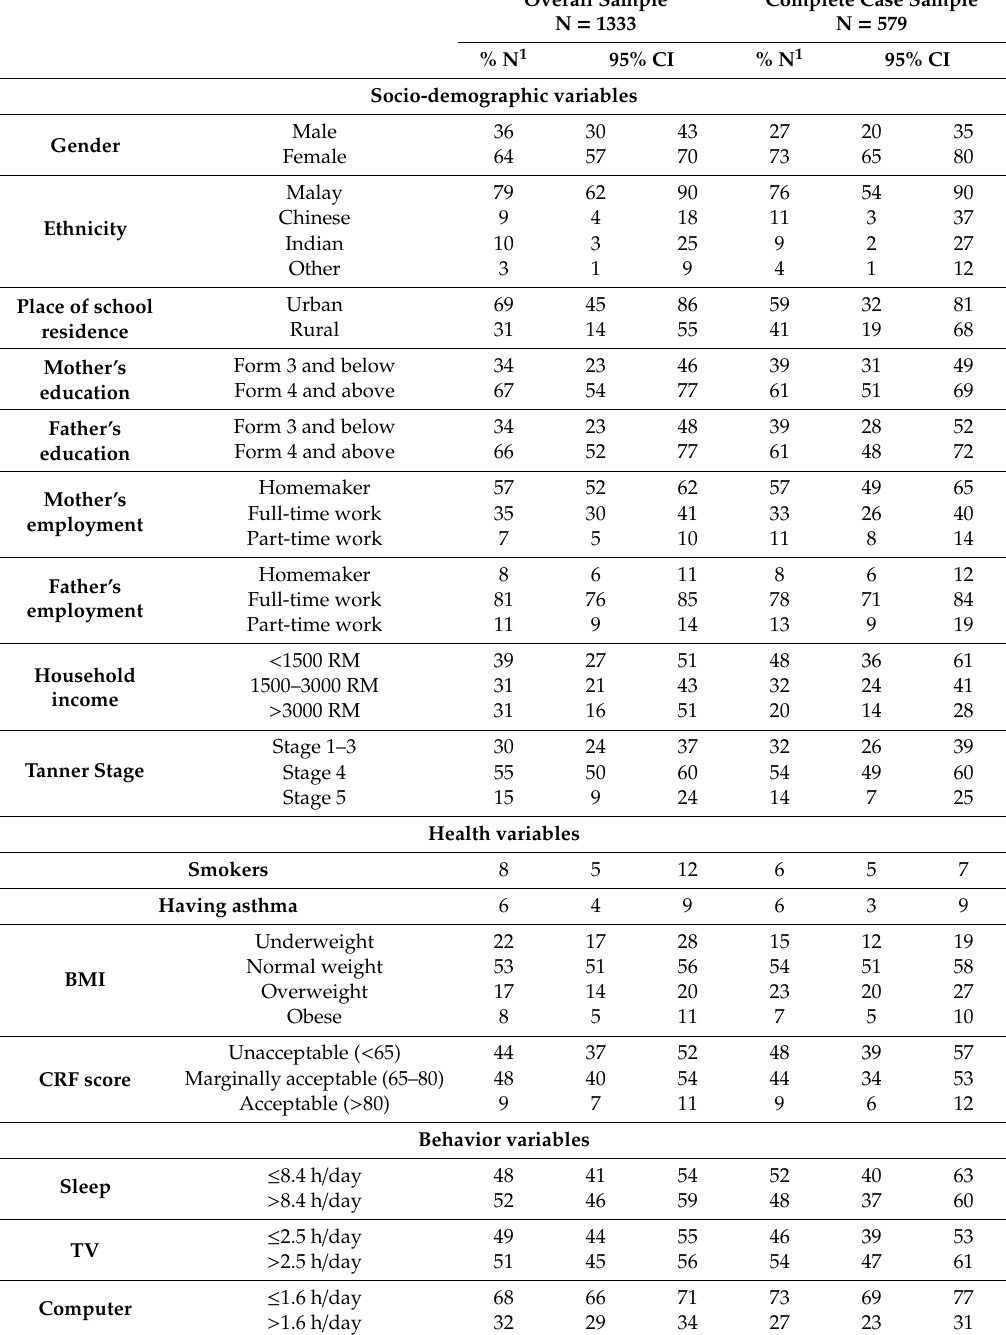
Table 1. Description of adolescents at 13 years in the overall and smaller sample with all data required for longitudinal associations (complete case